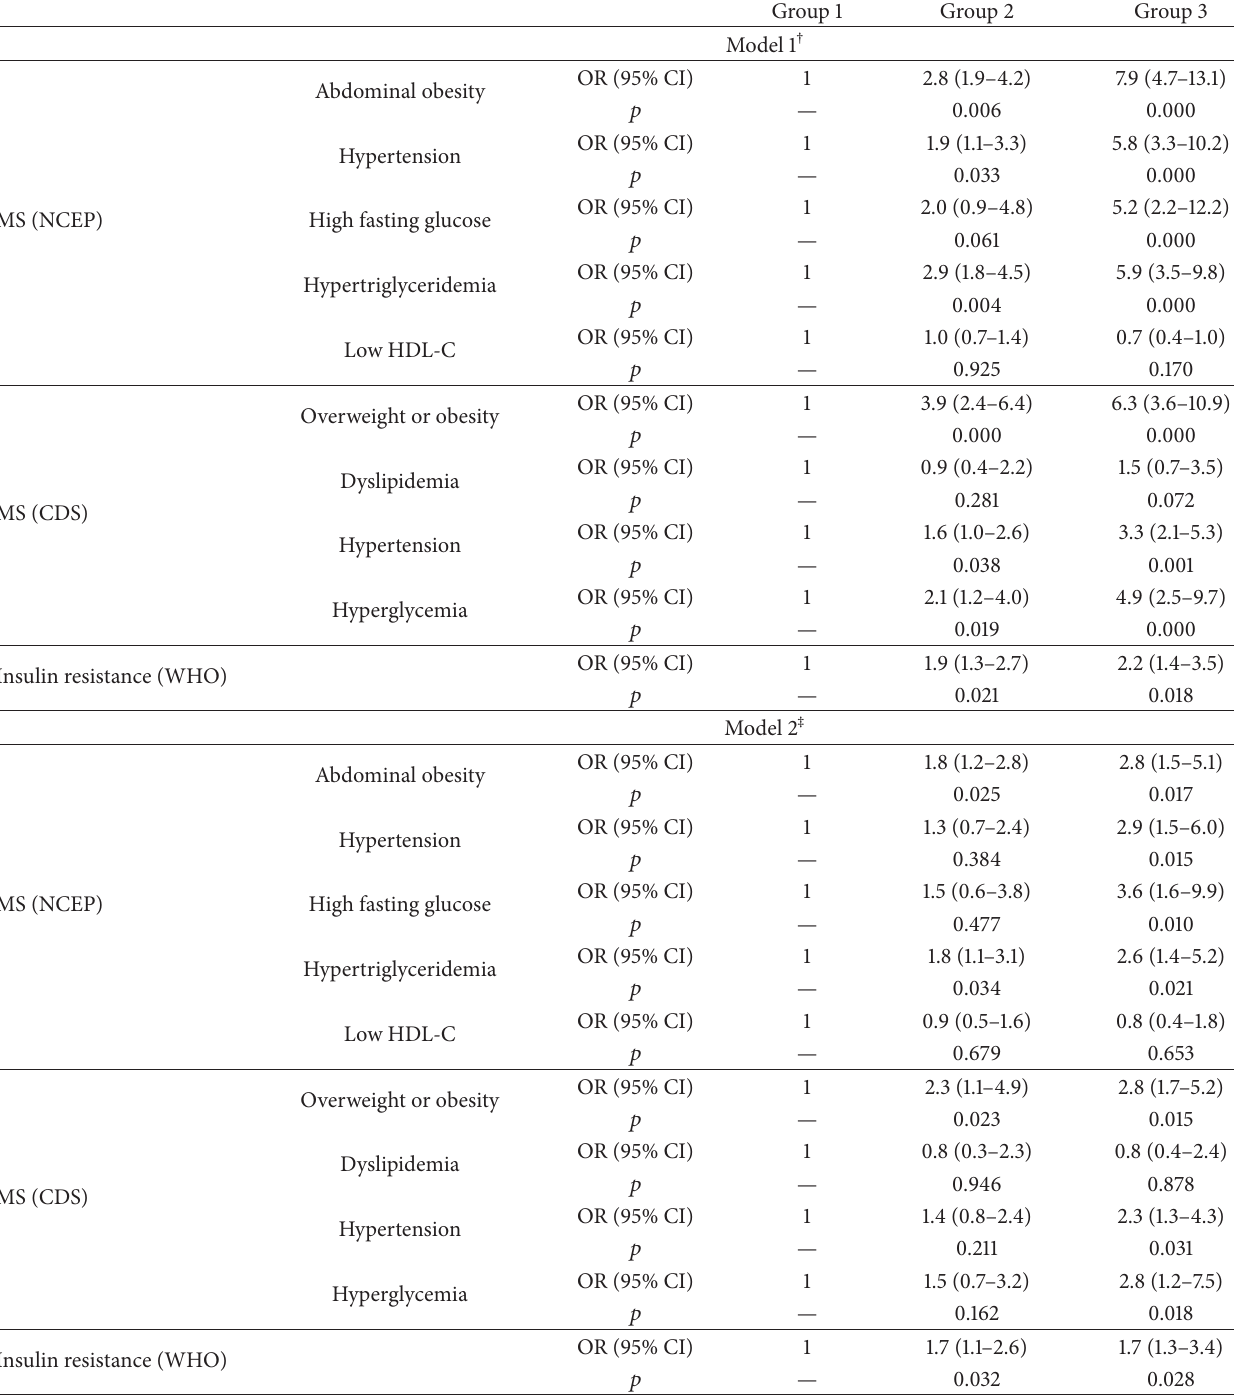
Table 4: Odds ratios (95% CI) and p values for components of the metabolic syndrome by GGT and ferritin levels in